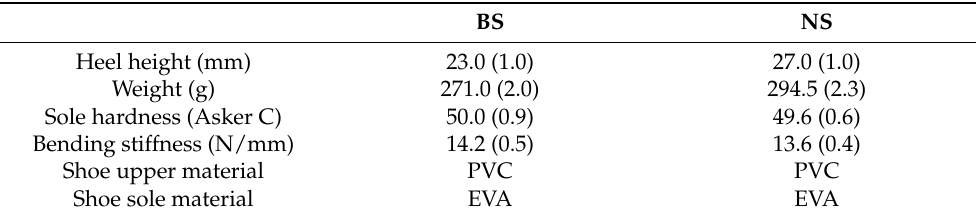
Table 1. Illustration of the specific details between bionic shoes (BS) and normal shoes (NS).